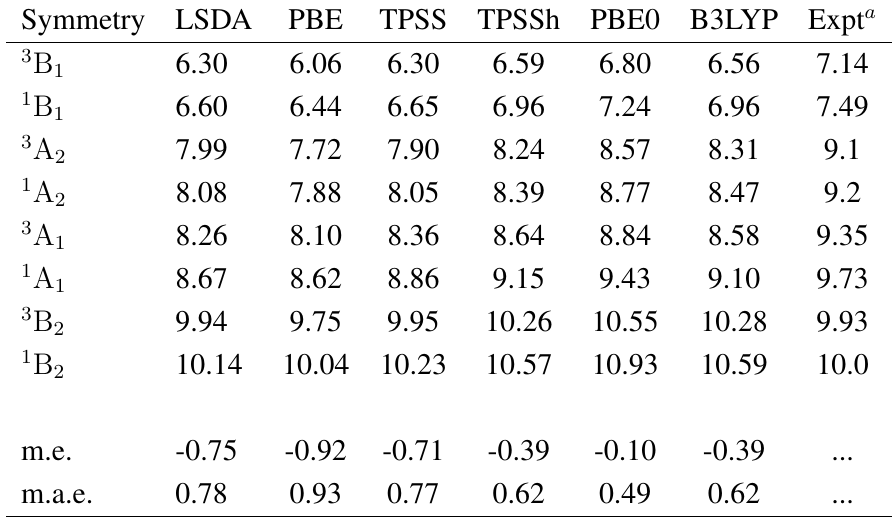
O. The mean experimental value is 8.99 eV. 2